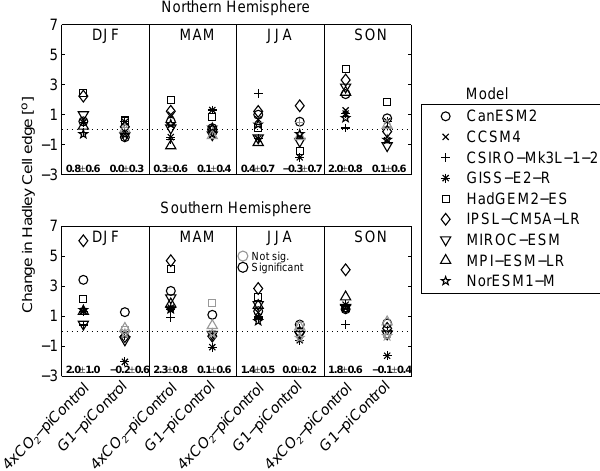
Figure 4. The change in the Hadley cell edge latitudes and width be- tween the 4 × CO 2 and piControl experiments and between the G1 and piControl experiments, for the Northern Hemisphere and South- ern Hemisphere edge latitudes and for the total change in Hadley cell width. Positive values indicate poleward expansion or an in- crease in width. Models with edge latitude or width changes sig- nificant at the 95% confidence level are shown in black. The mean change in the tropical belt width or edge latitude and its 95% con- fidence interval in degrees latitude is shown at the bottom of each plot.